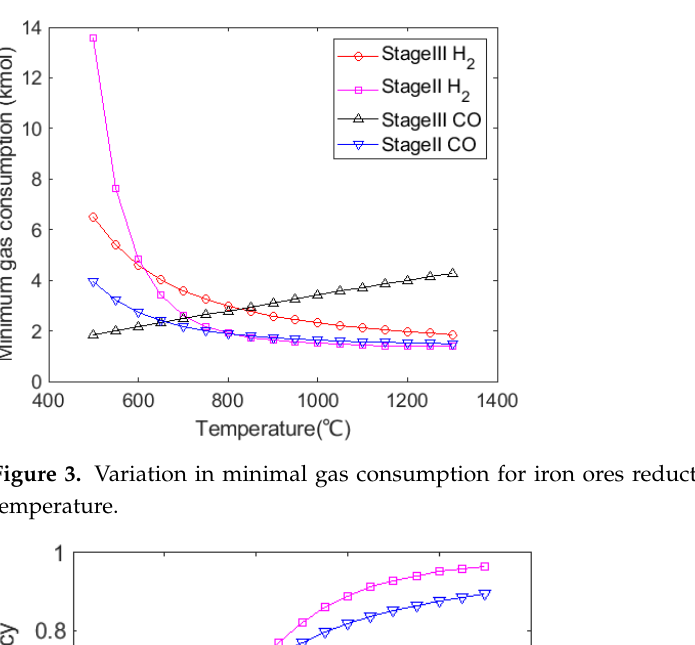
Figure 2. Heat effect of FeO reduction in H 2 –CO–N 2 gas mixture at ( a ) 35% N 2 and ( b ) 20% N 2 . H 2 content entering blast furnace shaft is indicated by different colours.